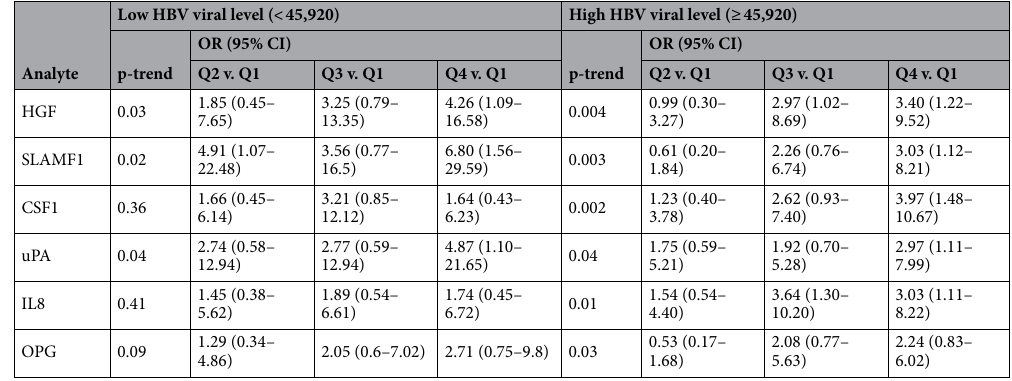
Table 3. REVEAL-HBV odds ratios* and 95%CIs stratified by viral load. *Adjusted for age, sex, years of follow up, HBV viral load, serum alanine aminotransferase (ALT) level, alcohol, smoking, and HBV e antigen (HBeAg).